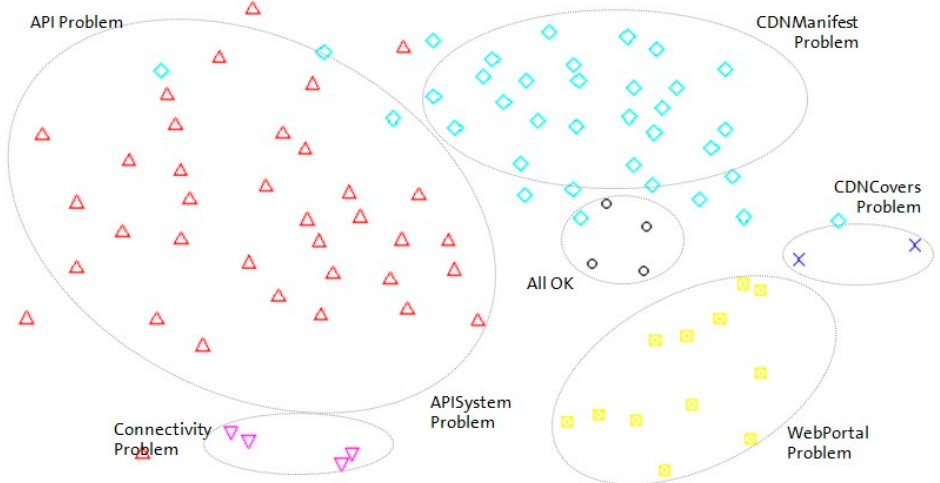
Figure 8. Fault root cause clusters.